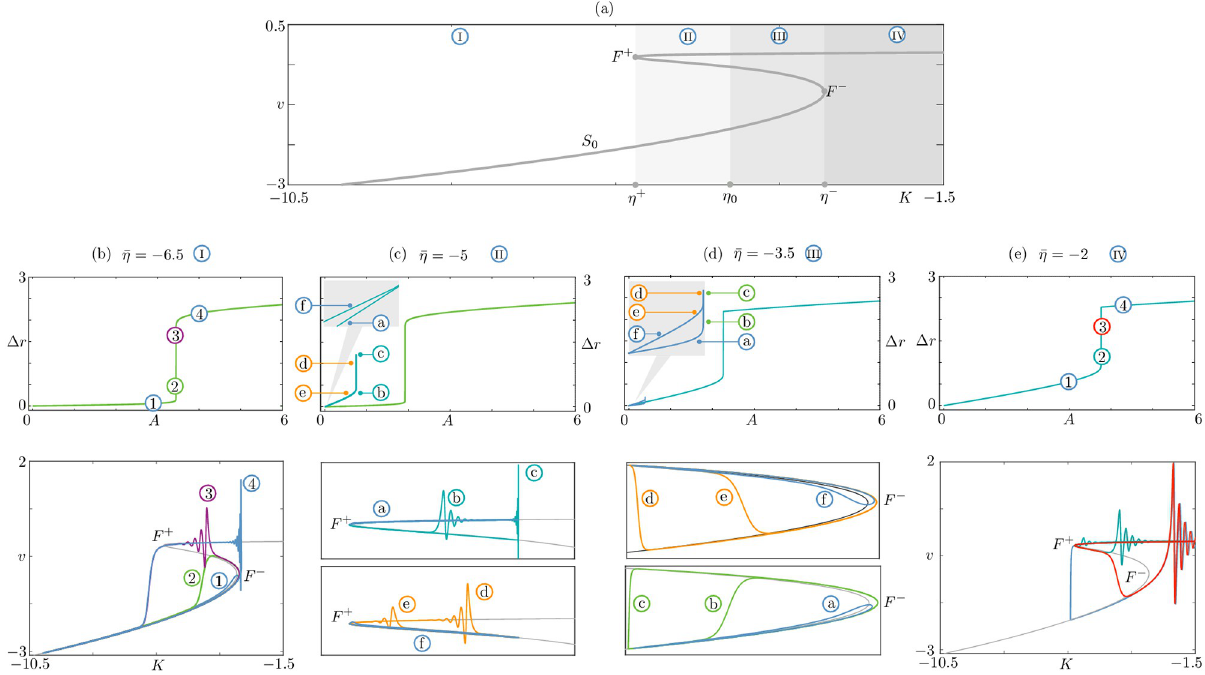
Fig 6. Continuous routes to bursting and non-bursting solution branches, in the mean field model (4) for four different values of � Z corresponding to the four different scenarios described in the main text. The associated four regions I, II, III and IV are highlighted on top of the critical manifold S 0 in panel (a). The three values of � Z at the transitions between these scenarios are denoted η + ≔ η ( F + ), η − ≔ η ( F − ) and η 0 = ( η + + η − )/ 2, where F ± are the two folds of S 0 . The chosen values of � Z in each region are � Z ¼ (cid:0) 6 : 5 , � Z ¼ (cid:0) 5 , � Z ¼ (cid:0) 3 : 5 and � Z ¼ (cid:0) 2 , respectively. Panels (b–d) display both the solution branches obtained by varying the forcing amplitude A for a given value of � Z (top), and a selection of solutions on the branch, plotted in the phase plane ( K , v ) on top of S 0 (bottom). As observed, a continuous branch of solutions bridging from the non-bursting regime to the bursting regime always exists, regardless of the � Z value. This branch connects in parameter space a down-down non-bursting solution to a down-up bursting one for � Z < Z (panels b,c), or an up-up non-bursting solution to an up-down bursting one for � Z > Z (panels d,e). Additionally, for 0 0 Z þ < � Z < Z (cid:0) , another solution branch exists, starting at low A amplitude and which does not connect to the bursting regime; this branch contains up- (resp. Z < � Z < Z (cid:0) ). Parameter values are: Δ = 1, J = 15, τ = 0.02, ε = 0.05; � Z and A as indicated in the up (resp. down-down) solutions for Z þ < � Z < Z s 0 0